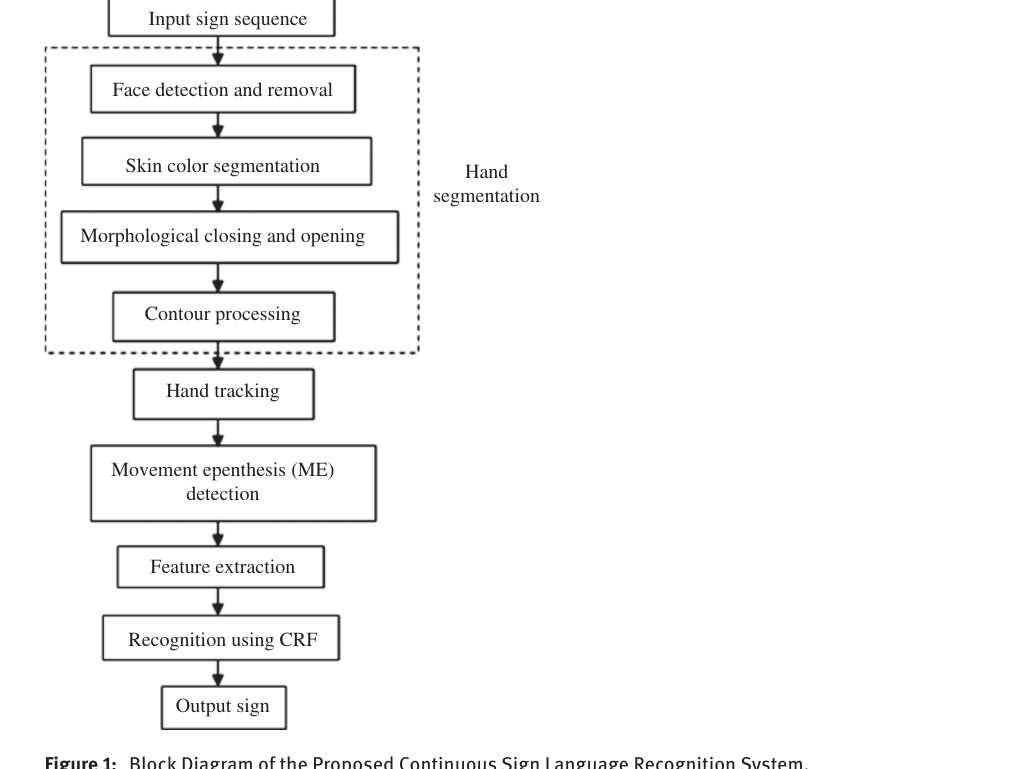
Figure 1: Block Diagram of the Proposed Continuous Sign Language Recognition System.